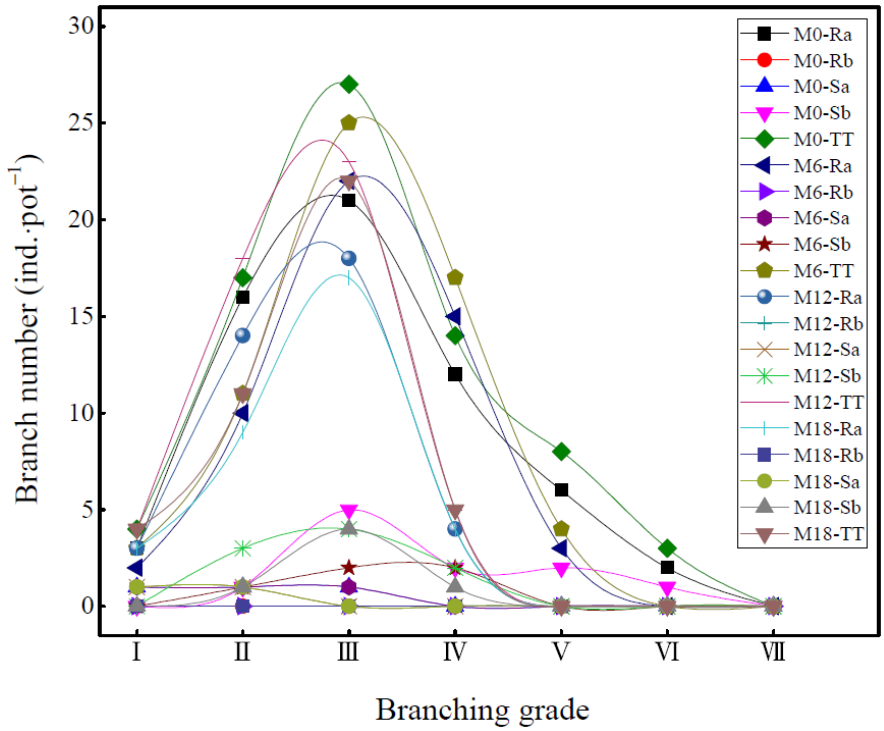
Figure 9. Variation trend of rhizome branching type.